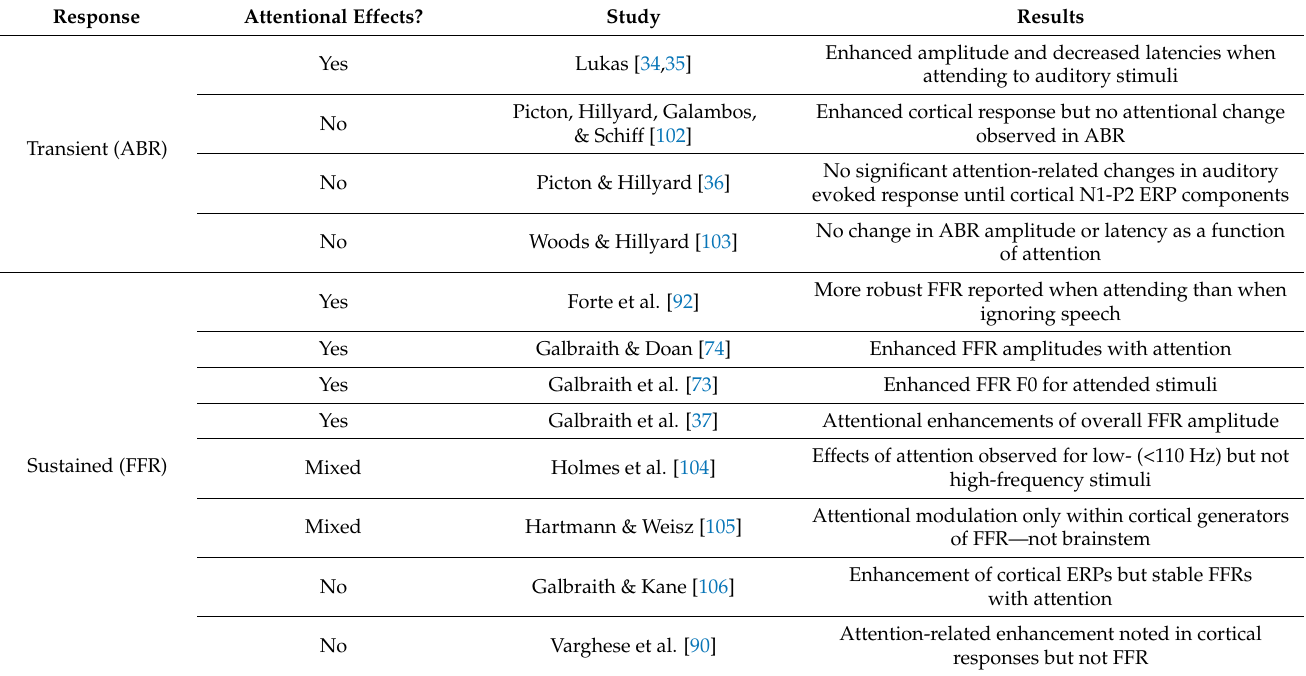
Table 2. Summary of studies evaluating attentional influence on evoked brainstem responses.